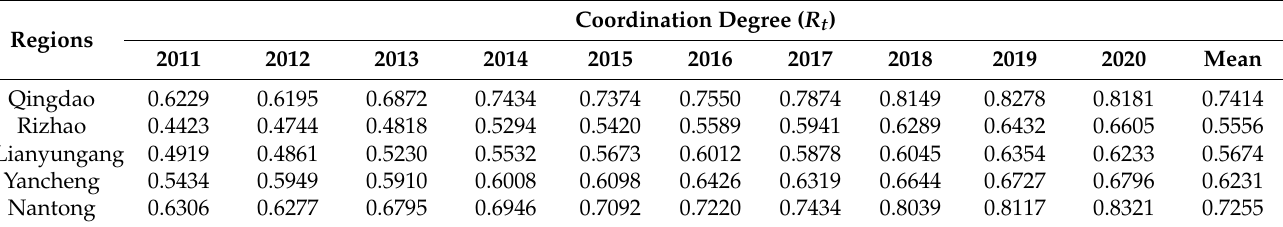
Table 6. The coordination degrees of the cities in the year 2011–2020.